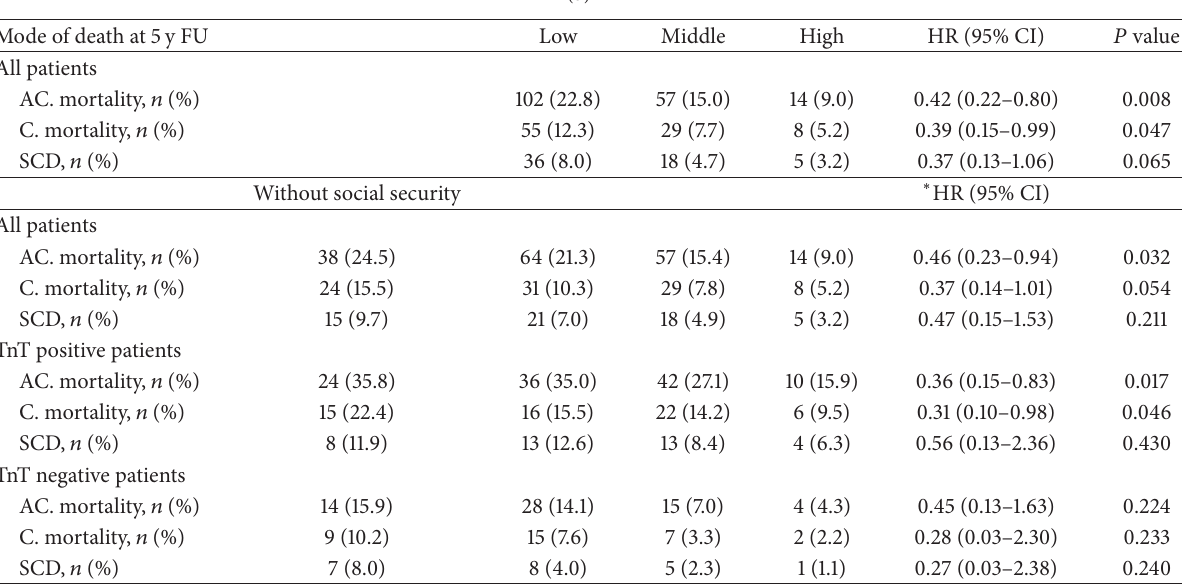
patients without social security as compared to the high socioeconomic group, in which all patients had a social security program. Variables potentially included in the stepwise multivariate model: gender, age, smoking, hypertension, index diagnosis, DM, CHF, history of